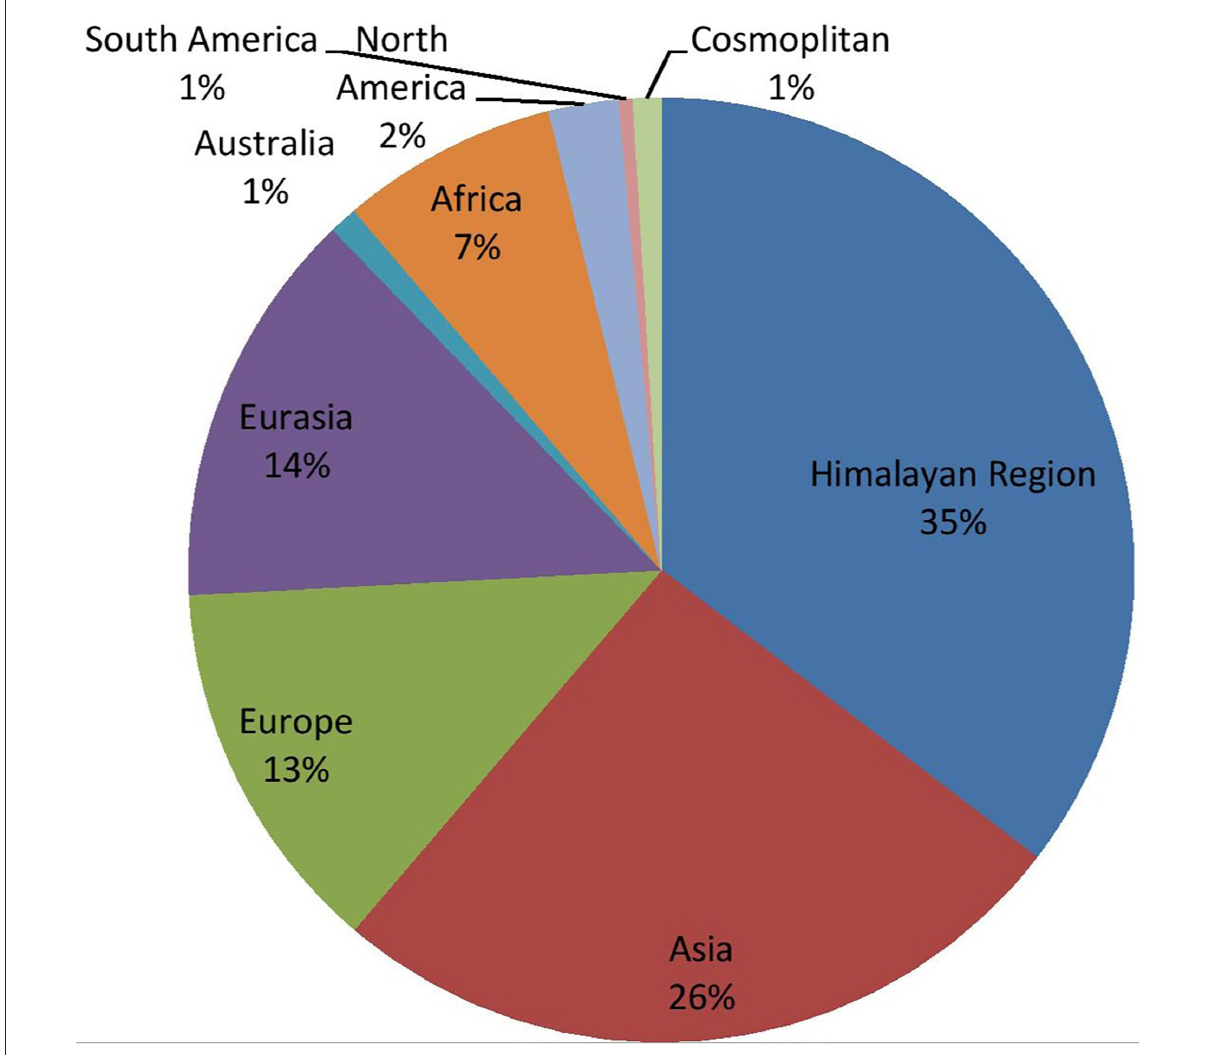
FIGURE3 Phytogeographic affinities of the recorded plant species from